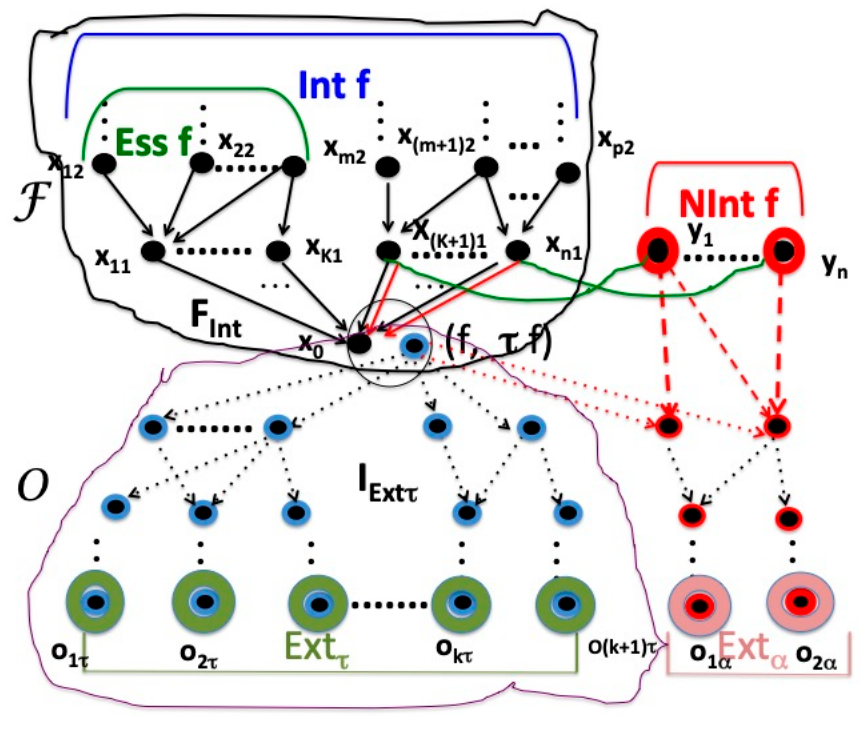
Figure 2. The network of LDO.